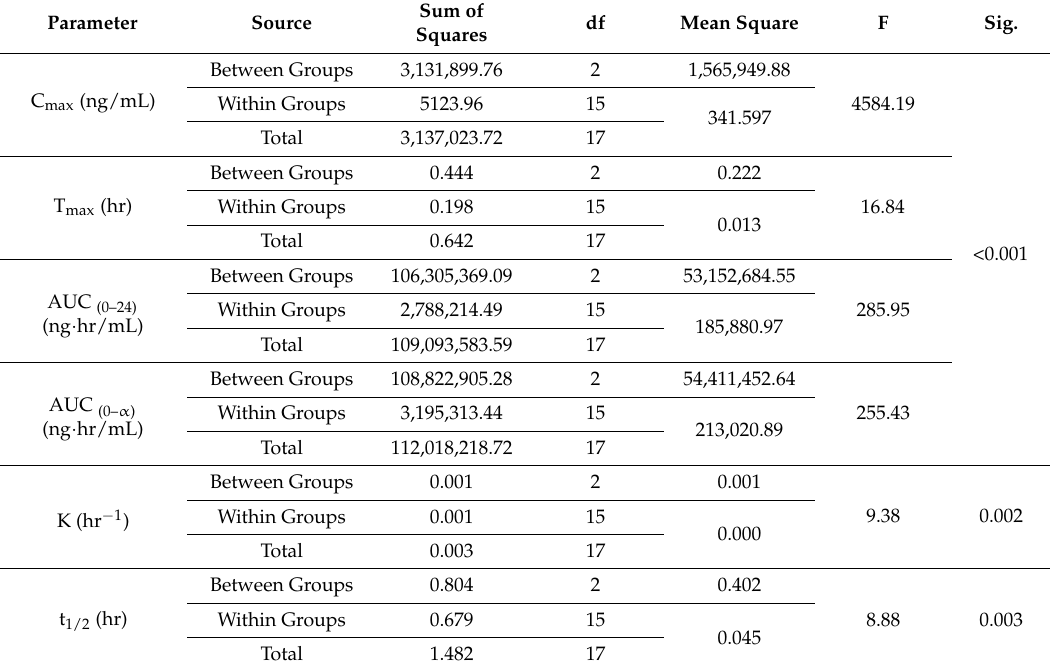
Table 5. One way ANOVA test for EPL pharmacokinetic data from different forms in rabbits. Parameter